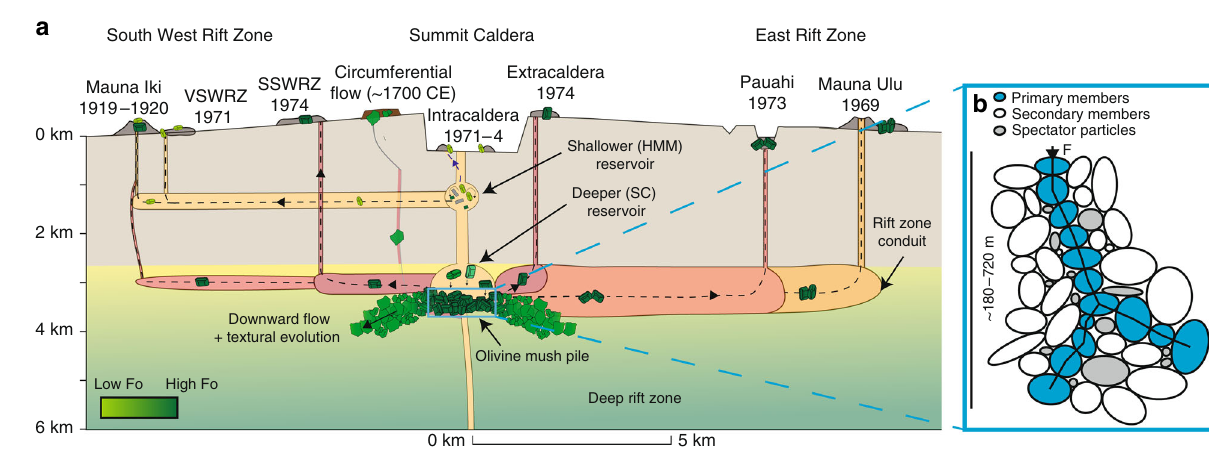
Fig. 9 Schematic cross section along the magmatic plumbing system of K ī lauea showing the formation of deformed olivines. a Olivine crystals in intracaldera eruptions thought to tap the shallower reservoir based on Pb isotope compositions (see refs. 67, 68 ) are largely undeformed. These crystals have evolved forsterite contents, close to the equilibrium composition of their matrix glasses. Extracaldera and rift eruptions, thought to tap the deeper SC reservoir based on Pb isotopes (see refs. 67, 68 ), entrain deformed crystals from melt-rich olivine mush piles at the base of the SC reservoir just prior to eruption. The Mauna Iki eruption taps a mixed crystal cargo, from the upper and lower reservoir (see ref. 37 ). The ~1700 eruption and the K ī lauea Iki eruption (see ref. 6 ) may tap olivine bodies that have begun their descent into the deep rift zones. b Schematic diagram of force chains within granular olivine mush piles (adapted from the ref. 60 ). Primary members can experience forces ~6× the mean force, secondary members experience less than the mean force, while spectator particles experience no force.